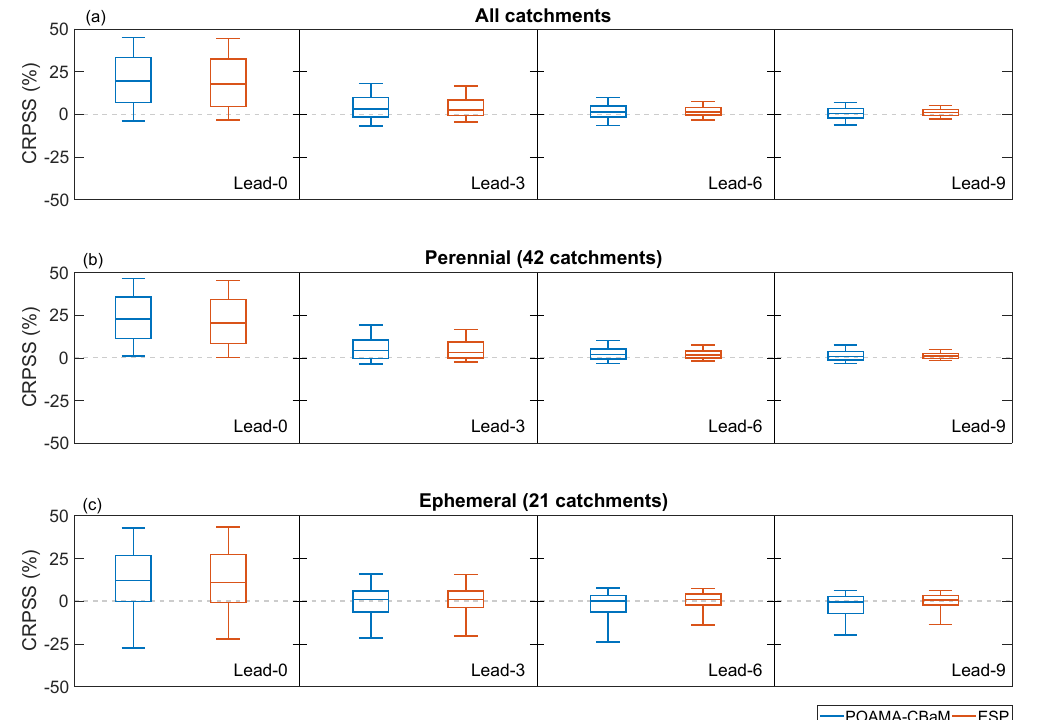
Figure 6. Skill (CRPSS) for 63 catchments by lead time for FoGSS forecasts forced by forecast (POAMA-CBaM) and historical (ESP) rain- fall. For each lead time, forecast skill is summarized for all months and catchments with box and whisker plots. Boxes show the interquartile range with the median; whiskers give the 10th and 90th percentiles. (a) shows all catchments, (b) shows perennial catchments, and (c) shows ephemeral